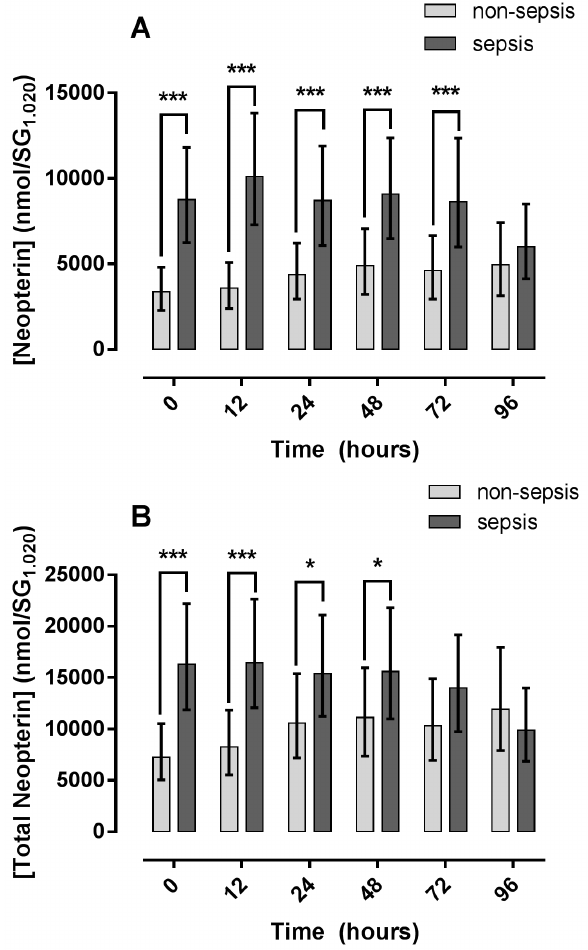
Figure 1: Urinary neopterin (A) and total neopterin (B) of non-sepsis and sepsis patients over 96 hours. Sepsis urinary neopterin levels are significantly elevated over non-sepsis up to 72 hours. Urinary total neopterin (uTNP) is elevated for the first 48 hours for sepsis versus non-sepsis. Data is presented as means and their respective 95%